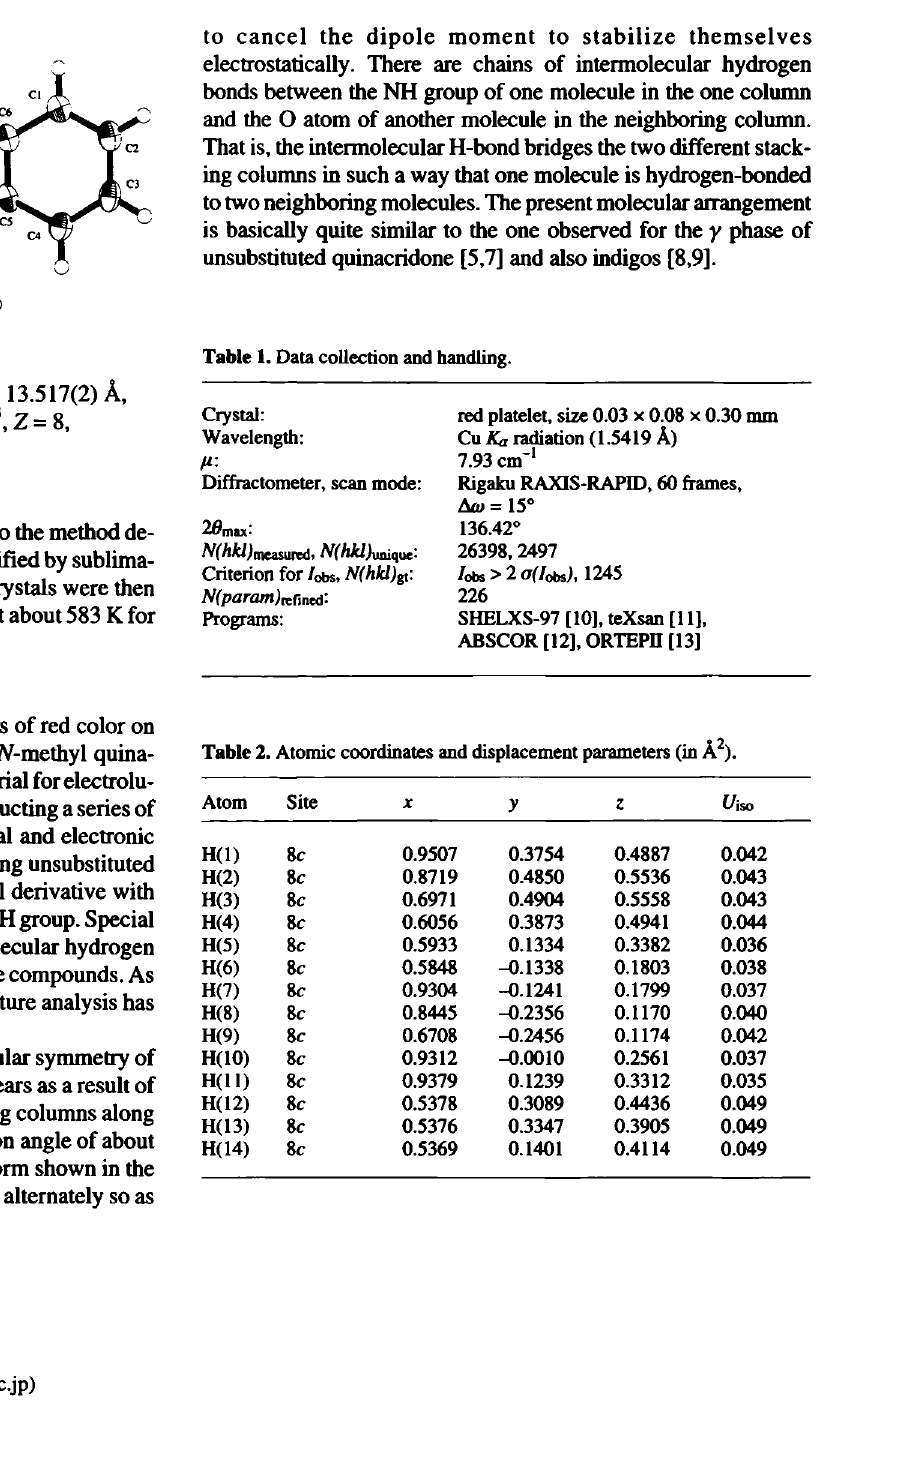
Table 2. Atomic coordinates and displacement parameters (in À 2